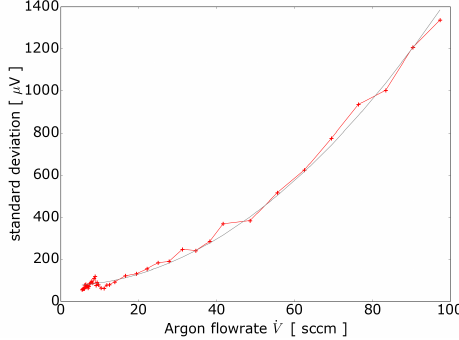
Figure 8. Quadratic dependence of the standard deviation of the induced voltage with the argon flow rate. The red line are the measurements and the grey line is a quadratic fit to the measurement